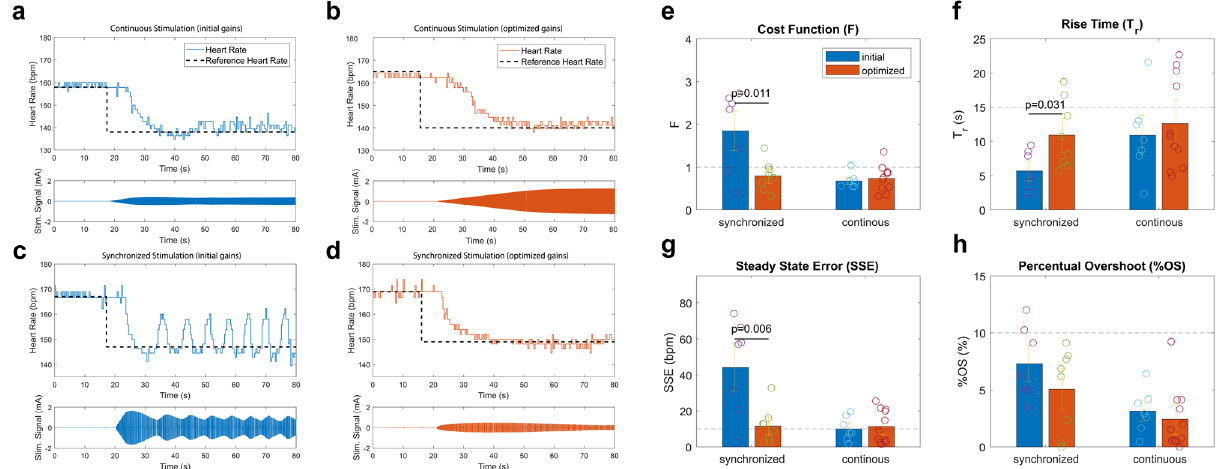
Figure 4. Exemplary heart rate response along with the corresponding stimulation signals for a step reduction of 20 bpm from baseline for ( a ) K p = 0.01, K i = 0.05 and ( b ) K p = 0.008, K i = 0.01 using the continuous control strategy, and for ( c ) K p = 0.001, Ki = 0.005 and ( d ) K p = 0.0005, K i = 0.003 using the cardiac-synchronized control strategy recorded in one isolated heart. Overview of the strategy performance on the whole study population as quantified by ( e ) the cost function, ( f ) rise time, ( g ) steady-state error, and ( h ) percentual overshoot for the initial and optimized controller gains. Differences in the mean performance indicators were tested using a two- tailed Student-t